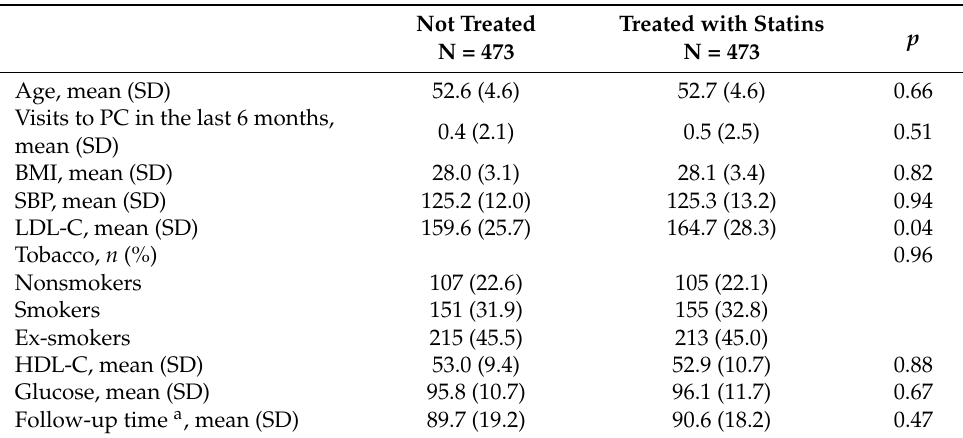
Table 2. Characteristics of the total subject-trials in the matched